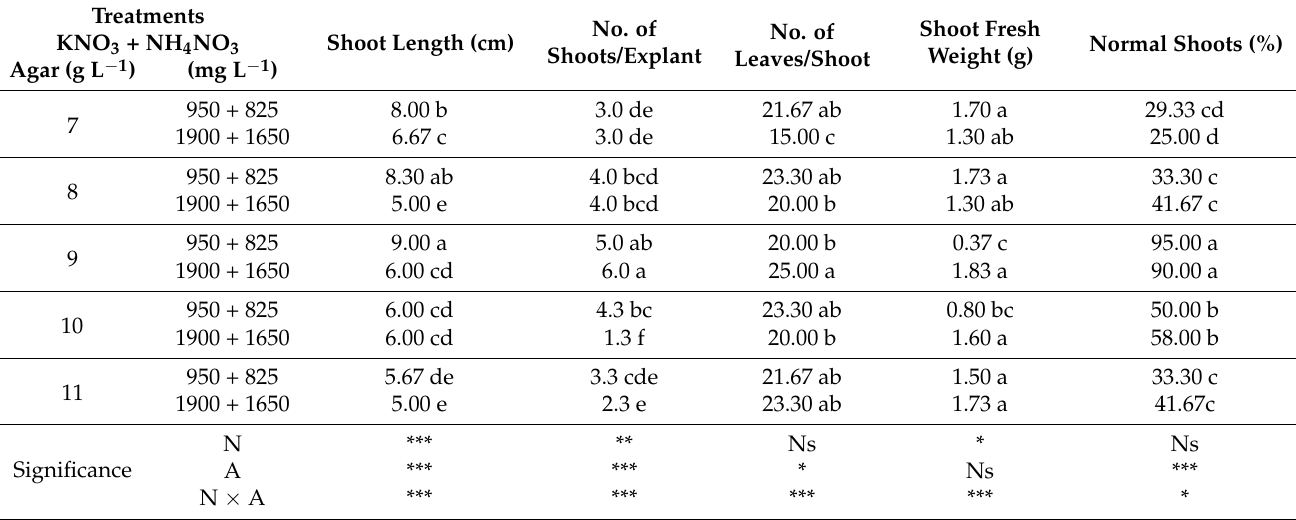
Table 3. Effect of agar and nitrate salts on growth and hyperhydricity reversion of G.